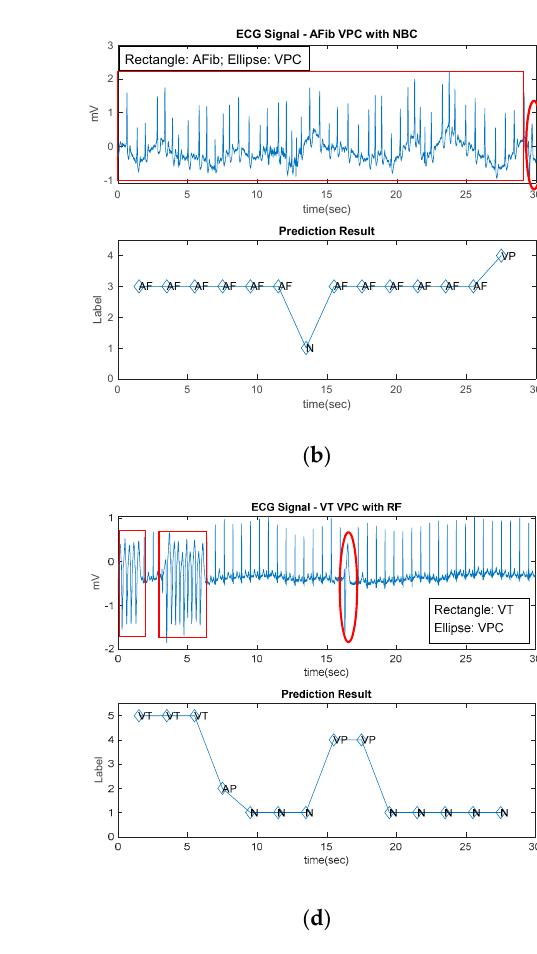
Figure 7. The traceable diagrams of arrhythmia symptoms recognized by the prototype of self-developed programs in comparison with the 30 s ECG segments around the interest timestamp: ( a ) APC by SVM for case #100 at approximately 17:27; ( b ) AFib–VPC by NB for case #203 at approximately 3:00; ( c ) VPC by RF for case #105 at approximately 0:32; ( d ) VT–VPC by RF for case #205 at approximately 5:15.